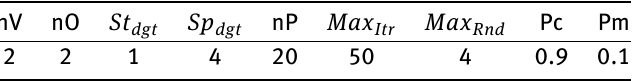
Table 4: VSSCGA Settings for Effati and Nazemi example 2